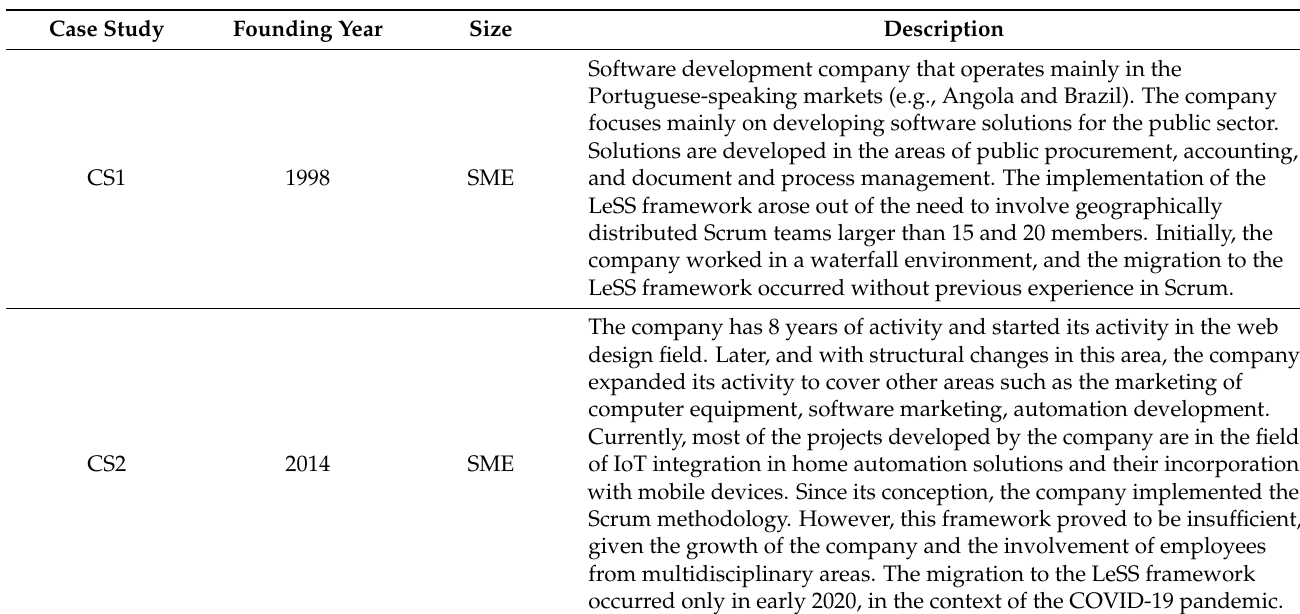
Table 1. Presentation of the case